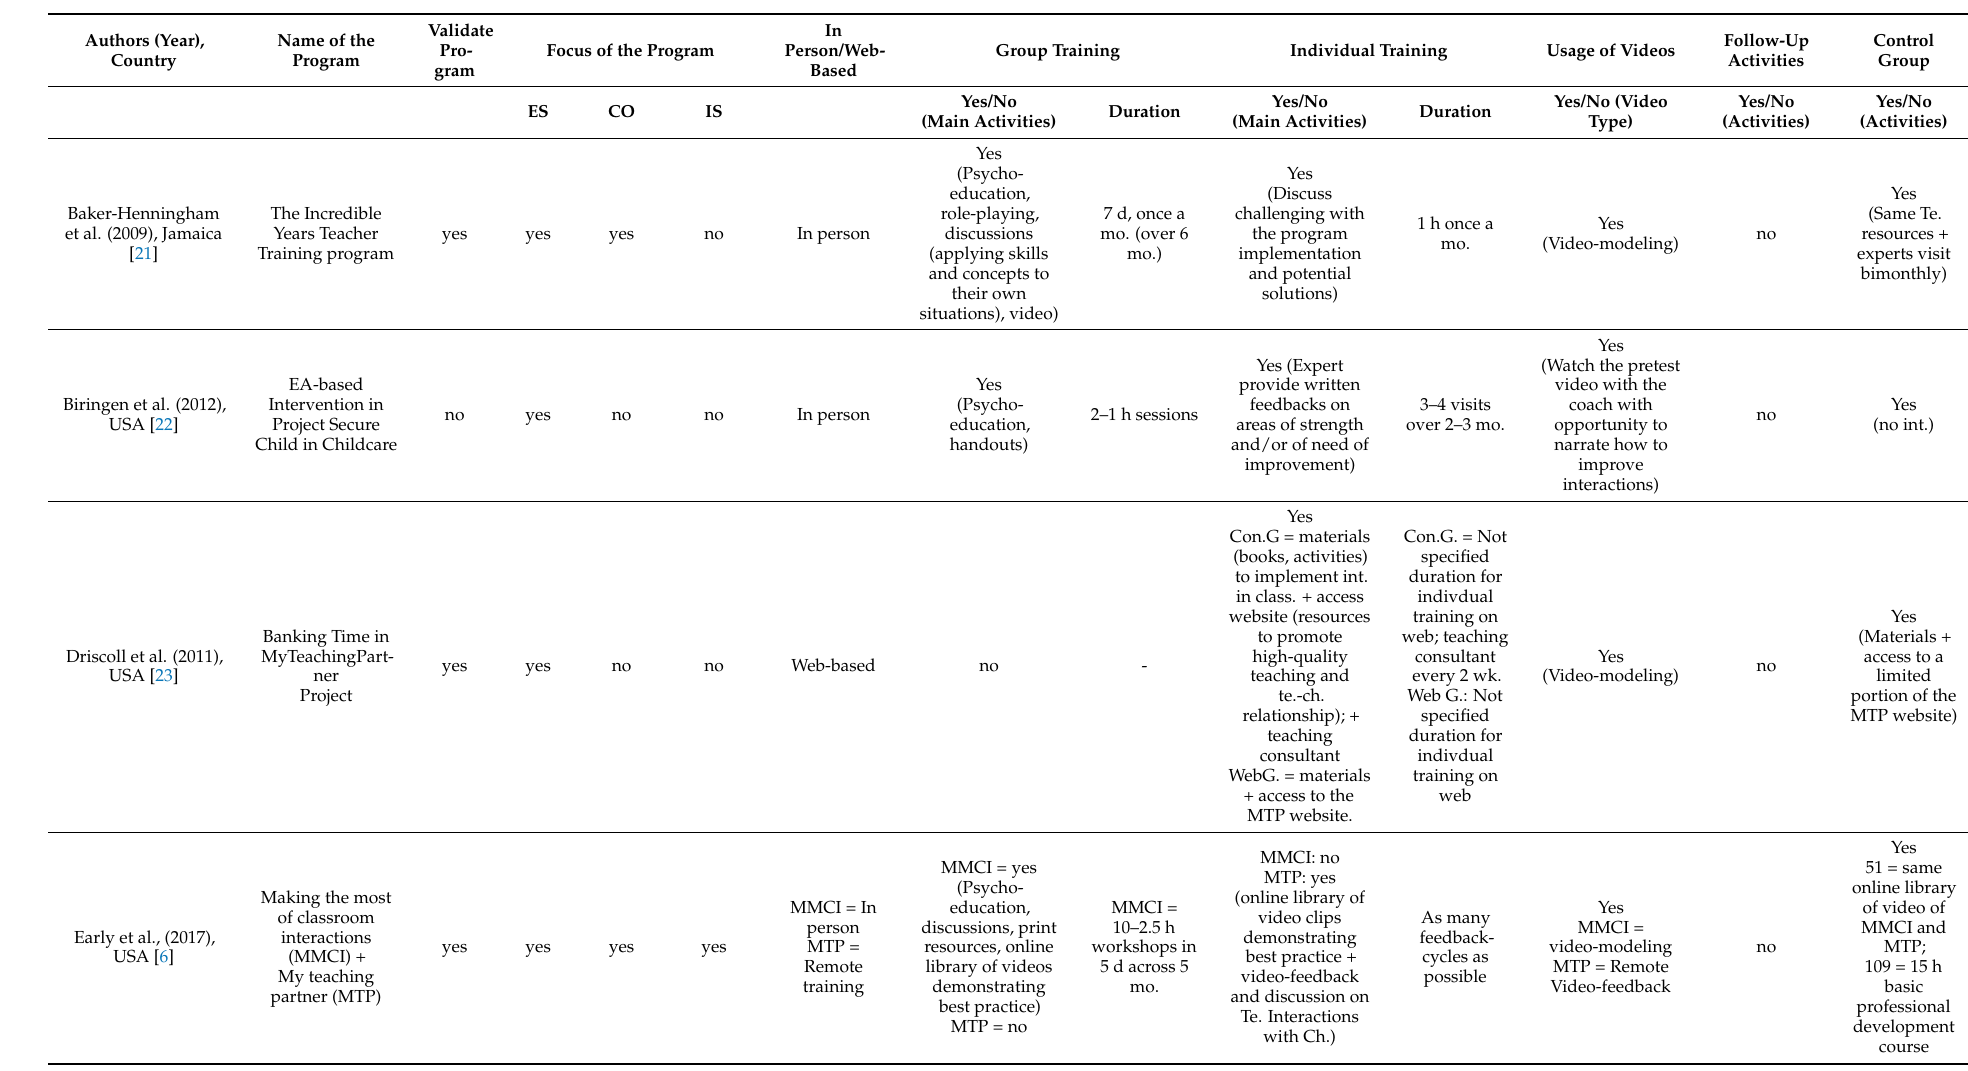
Table 2. Interventions’